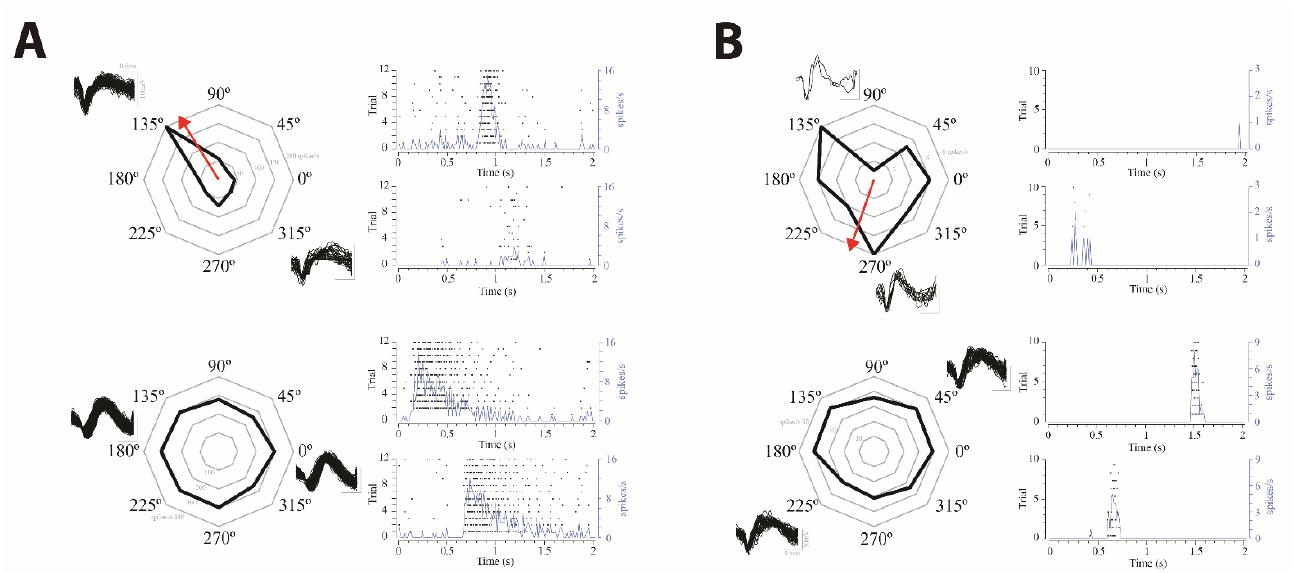
Figure 6. Directional selectivity in ON RGC. Examples of ON-RGC with directional selectivity (up) or without directional selectivity (down) recorded from the control retinas ( A ) and retinas from the NMDA/KA injected eyes ( B ). Each cell example includes a radial plot of the spike rate response to motion in eight directions across ten to twelve repetitions and the spike waveform, and the post stimulus time raster plot and cumulative recording line for the response to preferred (above) and the null (below) directions is also shown, ( B ). The red arrow indicates the preferred direction calculated as the vector sum of the response. Directional selective RGC from the NMDA/KA injected retinas shows an apparent broader response in the preferred direction than RGC from the control retinas.